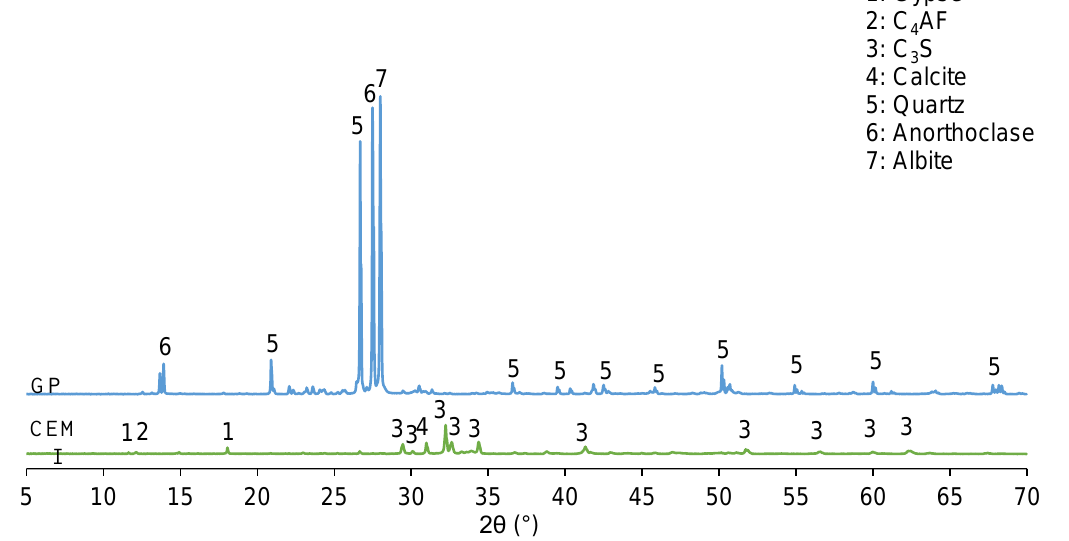
Figure 1. X-ray di ff raction patterns of cement and granite Figure 1. X-ray diffraction patterns of cement and granite powder.